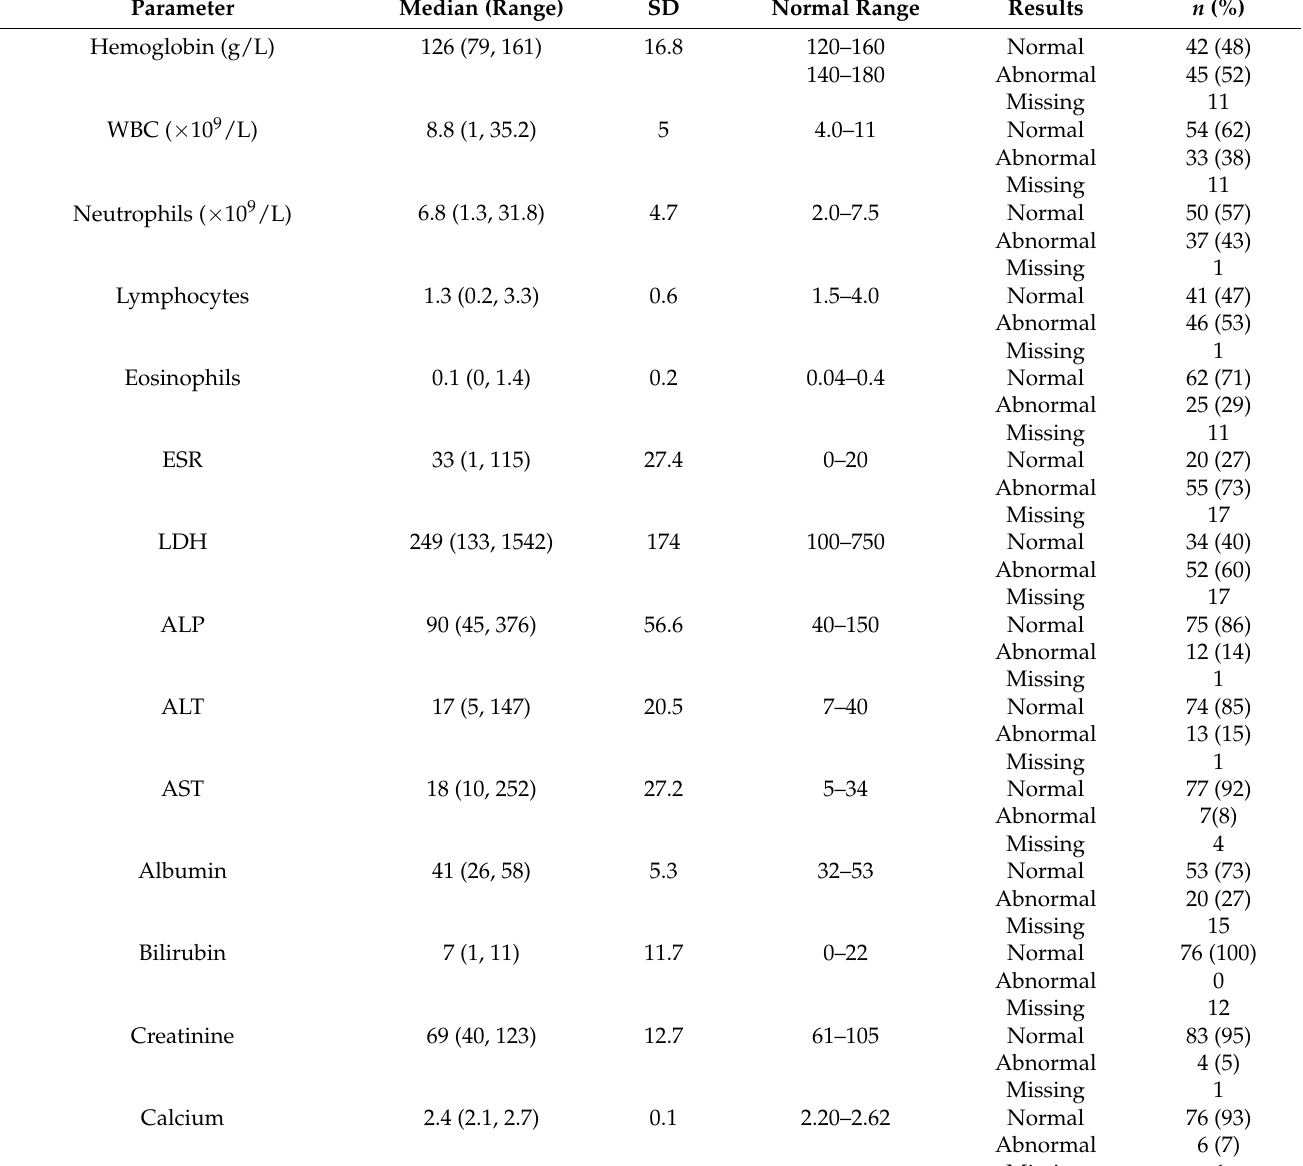
Table 2. Summary of Laboratory Parameters.